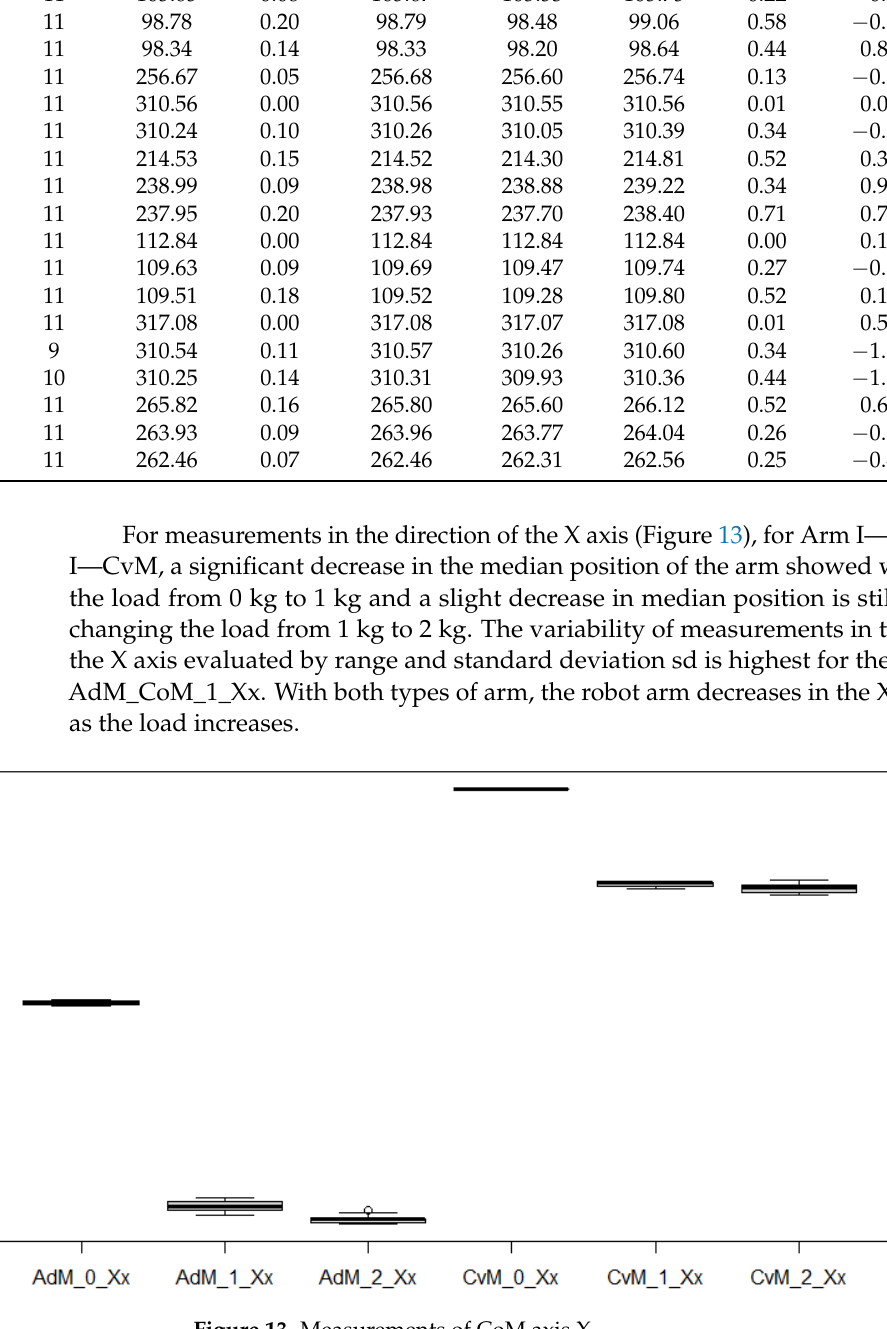
Table 7. CoM descriptive statistics for Arm I — AdM and Arm I — CvM.